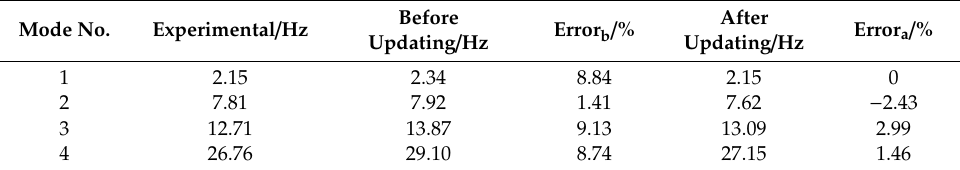
Table 7. Comparison of Frequency Values between FE Model and Experimental Model.